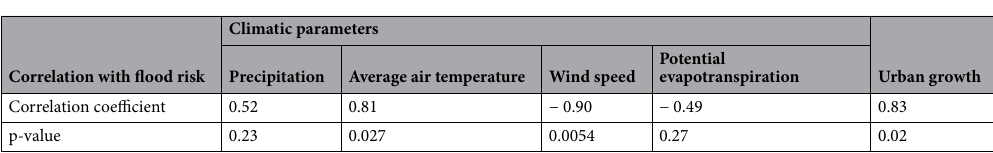
Table 2. The correlations flood risk has with urban growth and climate change. Sample size (n) = 7.